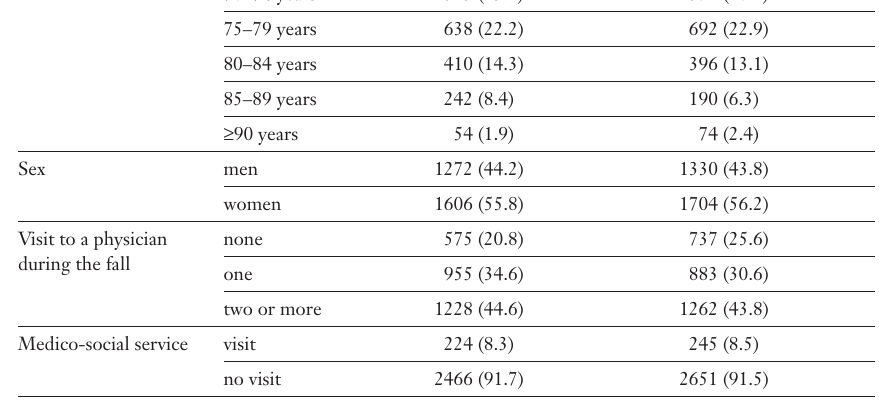
Patients characteris- tics in the two samples, N = 2931 in 2000 and N = 3092 in 2001.